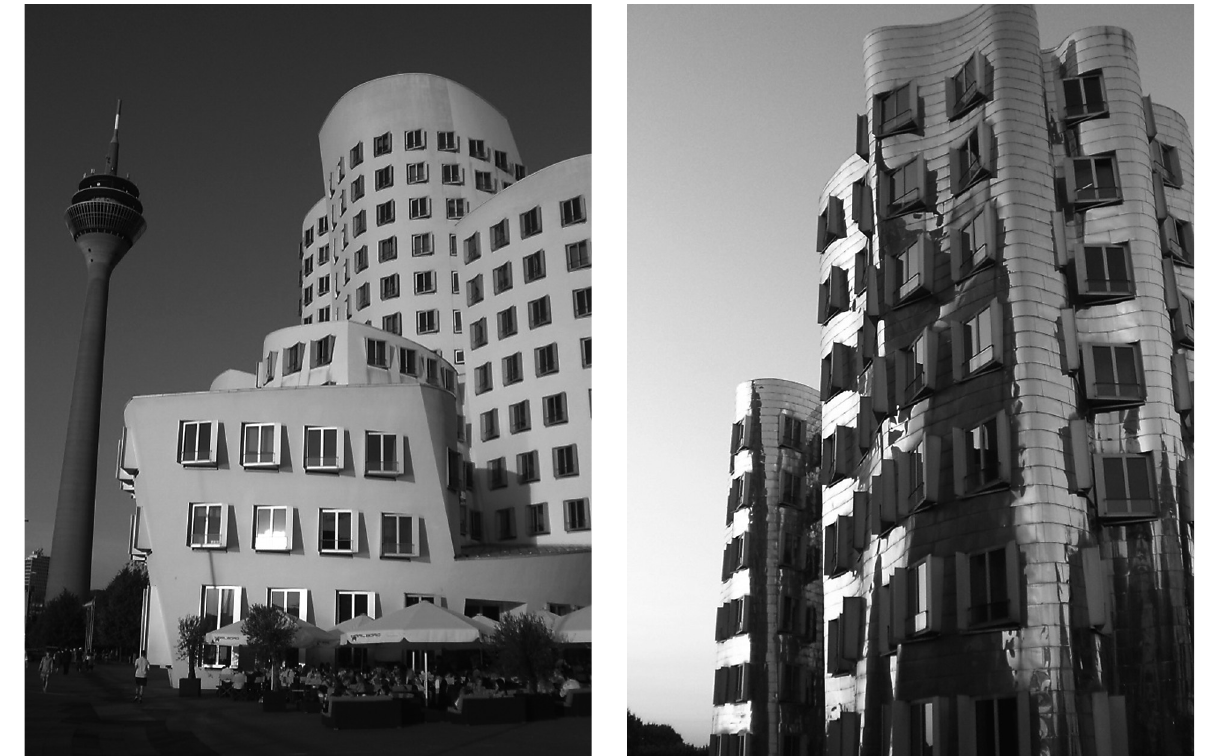
Fig. 1 & 2. The Media Harbour in Düsseldorf: Symbolic capital (photo by M. Otto,